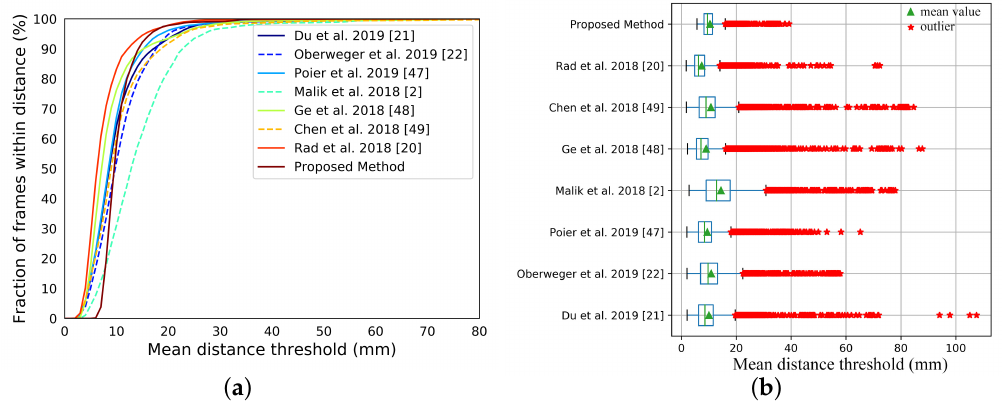
Figure 21. Experiment results on the NYU data-set. ( a ) The joints errors on the NYU data-set. ( b ) The box plot of the joints errors on the NYU data-set.